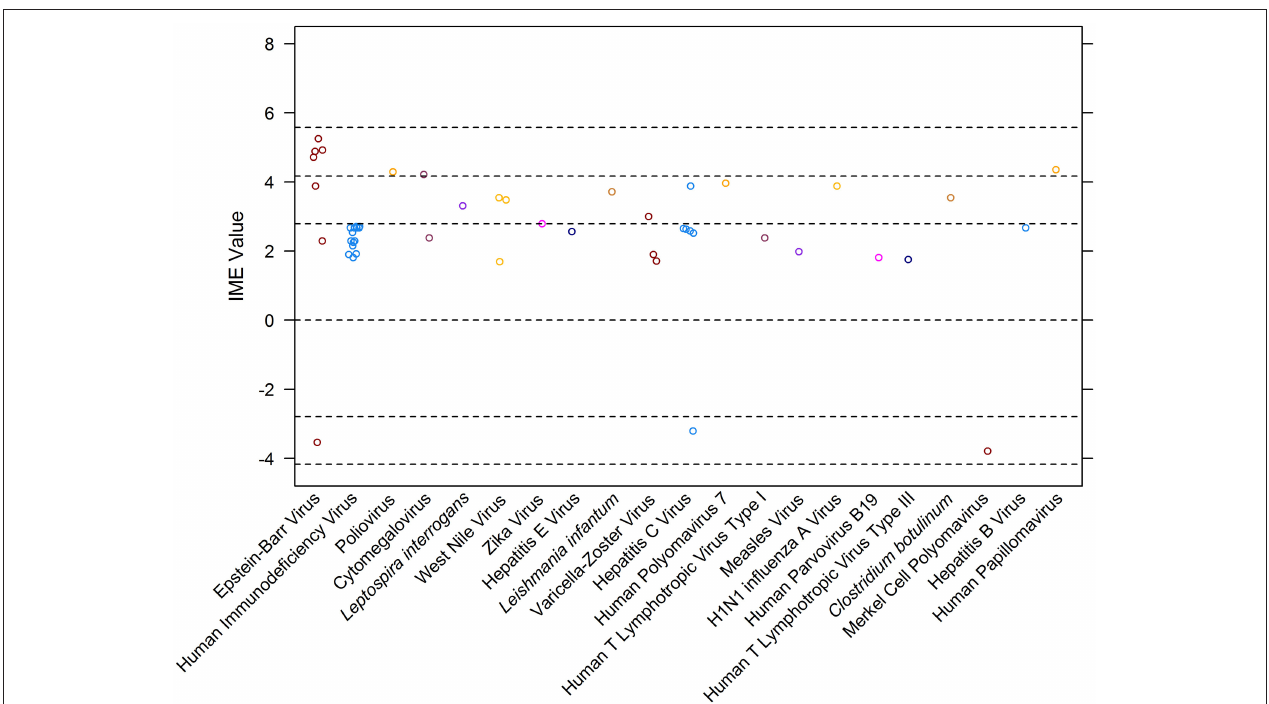
FIGURE 4 | Integrated metric of evidence (IME) values for infectious agents. Horizontal dotted lines indicate the threshold IME values between negligible and low (2.79), low and intermediate (4.14), and intermediate and high (5.58) levels of evidence. The median IME for the dataset is 2.63 (mean = 2.48; range − 3.79–5.25).